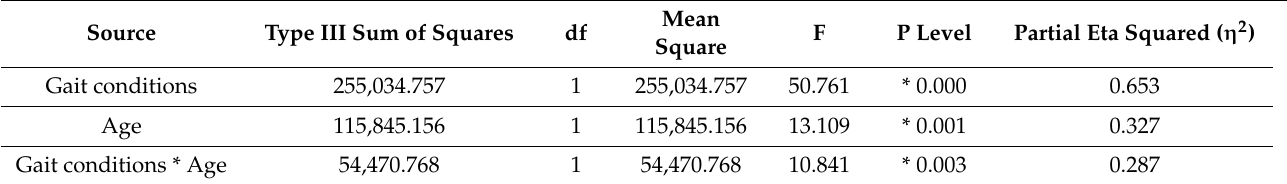
Table 1. Statistical results for within-subject and between-subjects effects (*: Statistical difference according to gait conditions, age, and interaction between gait conditions and age).